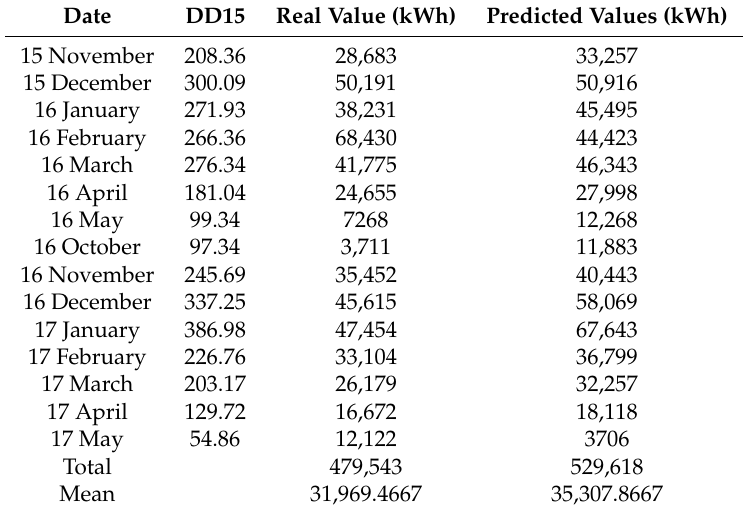
Table 8. Current and predicted consumption for building D3, from November 2015 to May 2017.